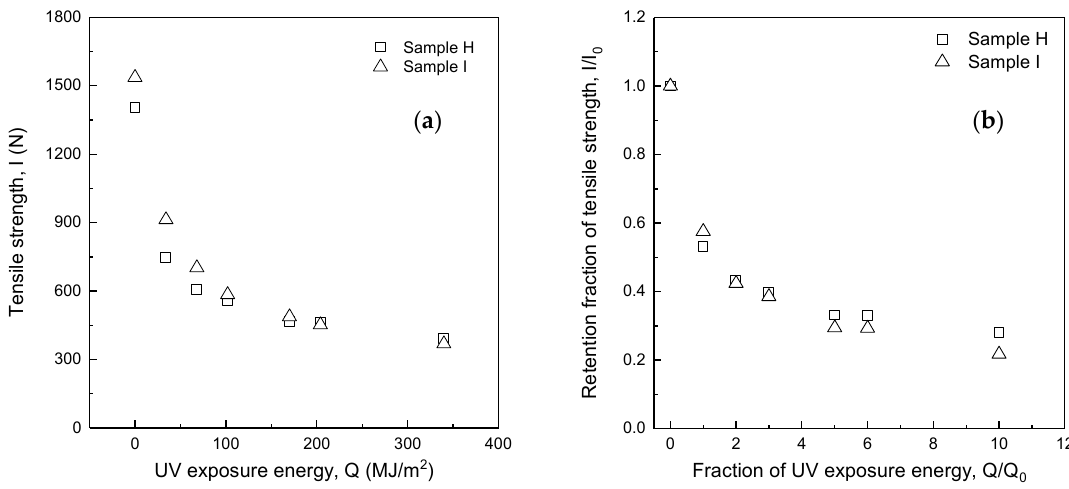
Figure 5. Tensile strength change ( a ) and retention fraction of tensile strength change ( b ) due to UV exposure with the same fiber blending ratio (m-Aramid 100%).